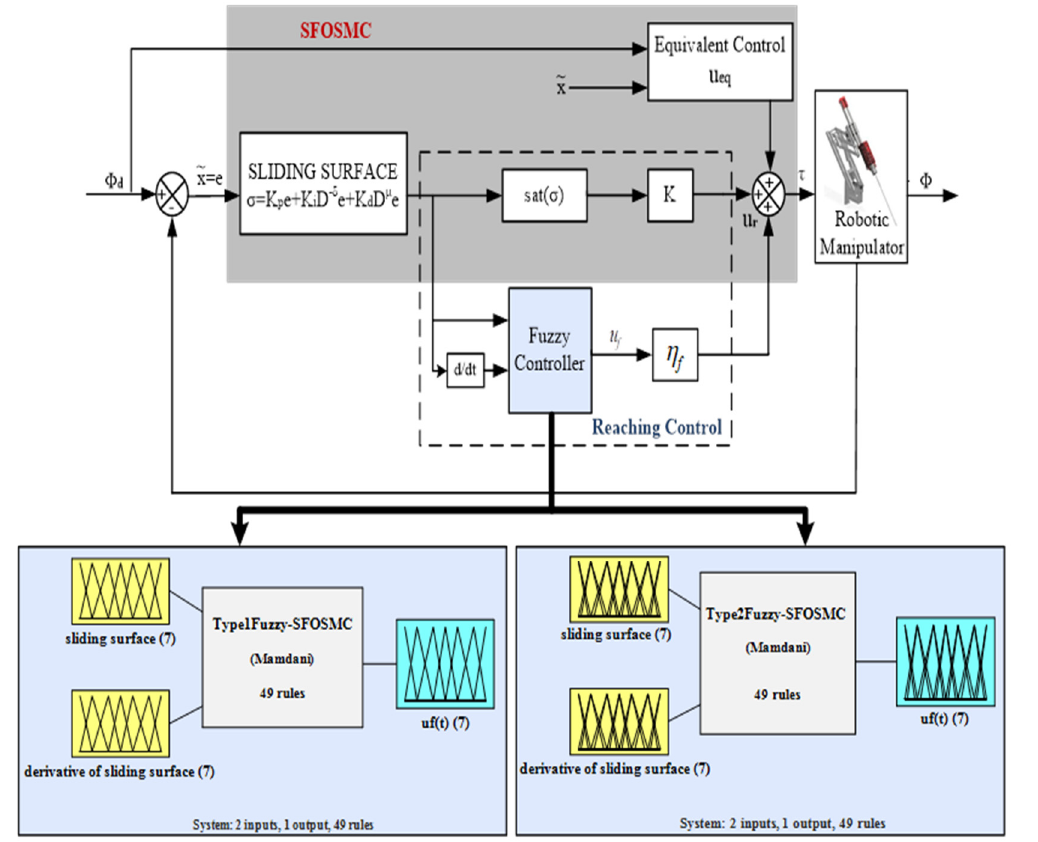
Figure 4. SFOSMC, T1F-SFOSMC and proposed T2F-SFOSMC controllers for surgical manipula- tors.